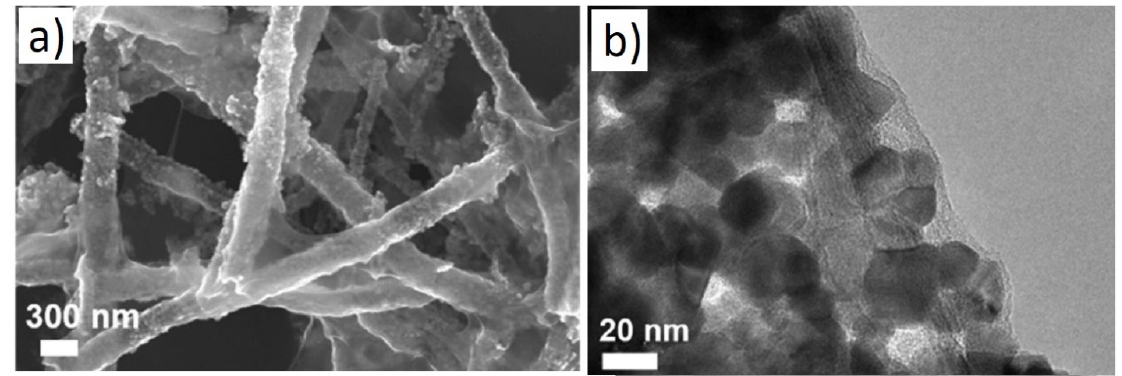
Figure 11. ( a ) SEM image and ( b ) TEM image of rGO-loaded SnO 2 hollow NFs [65].